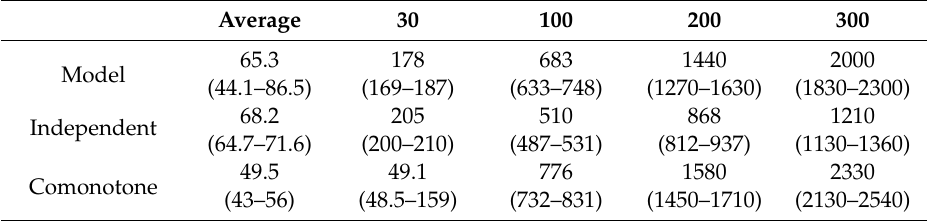
Table 5. Average yearly damage and estimated damage (in mio. € ) for floods with return periods of 30, 100, 200, and 300 years, for the municipalities with claim data. The damage is calculated with the Extreme Value Analysis (EVA) model and with three di ff erent dependence structures between the municipalities (the estimated dependence structure of this paper, independence and